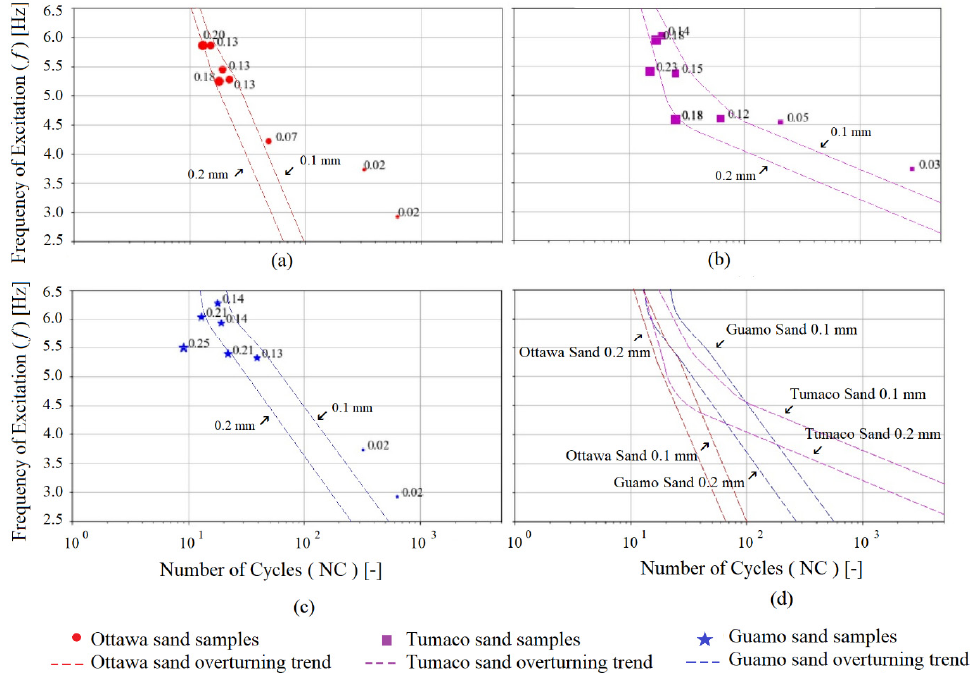
Figure 13. Cycles number at overturning according to frequency and amplitude of movement on the edge of the footing in oscillatory movement. The annotations in the markers refer to the amplitude on the edge of the footing. The sizes of the markers were proportional to the value of the amplitude on the edge of the footing: ( a ) Ottawa sand, ( b ) Tumaco sand, ( c ) Guamo sand, and ( d ) all samples’ overturning trends. Table 7. Test features and final results.